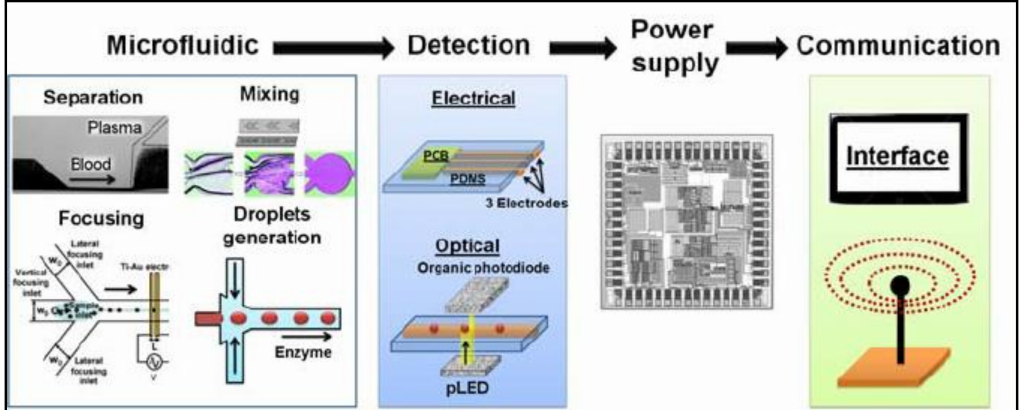
Figure 1. Typical setup of a self-contained microfluidic system that consists of four major sections: microfluidic chip where a type of microfluidic process occurs (mixing, separation, focusing, droplet generation, etc.); detection—optical, electrochemical, or mechanical detection methods are used to detect cells in the microfluidic chip; power supply to power the device; communication—gathered data is either analyzed on the device or communicated to separate device. Reproduced with permission from